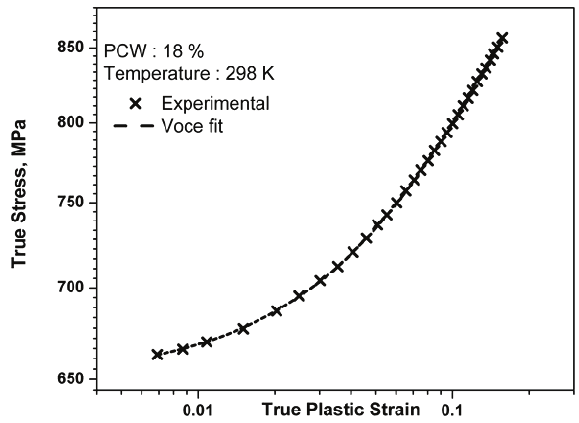
Figure 7. True stress-true plastic strain plot of 18% PCW material at 298 K fitted with Voce equation.